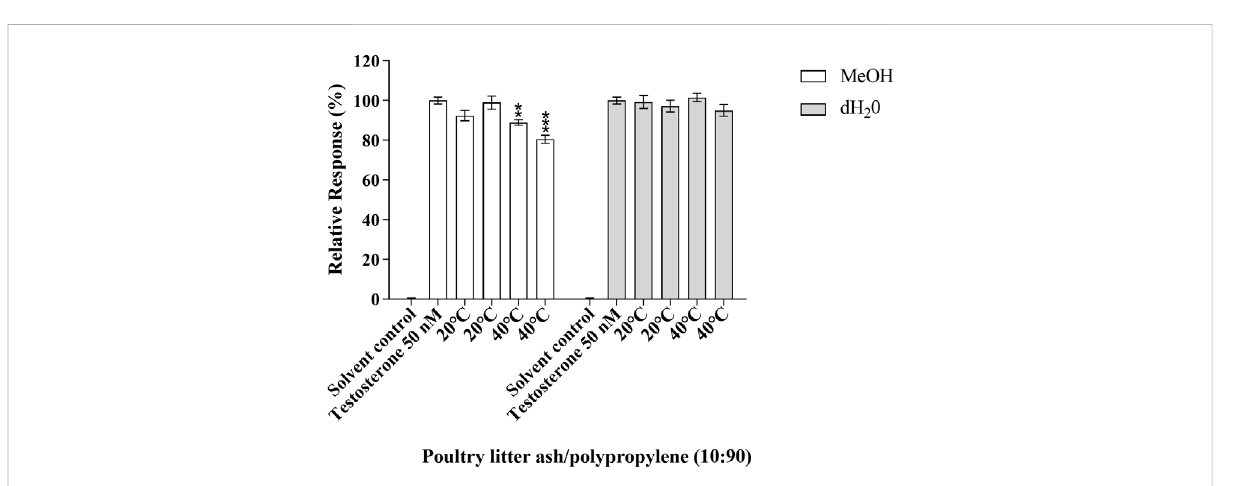
FIGURE 4 Antagonistic response of poultry litter ash/polypropylene (10:90) in the TARM-Luc (androgen responsive) cell line. Responses measured are compared to the solvent control (MeOH 0.5%) and positive control 14.5 ng/ml testosterone. Response is expressed as the percentage response ±SEM, n = 3. p ≤ 0.01 (**) and 0.001 (***).